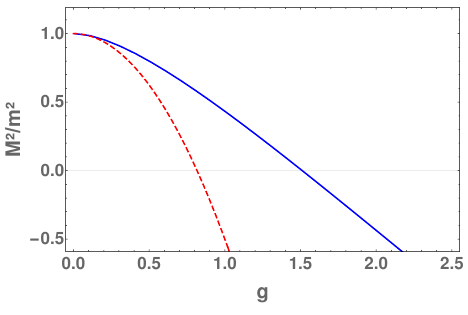
Figure 1 . The physical mass squared, in units of m 2 , as a function of g obtained with standard PT (dashed line) and OPT (continuous line) at the two loop level. The critical couplings occur at p g c = 2 / 3 = 0 . 82 (PT) and g c = 1 . 511